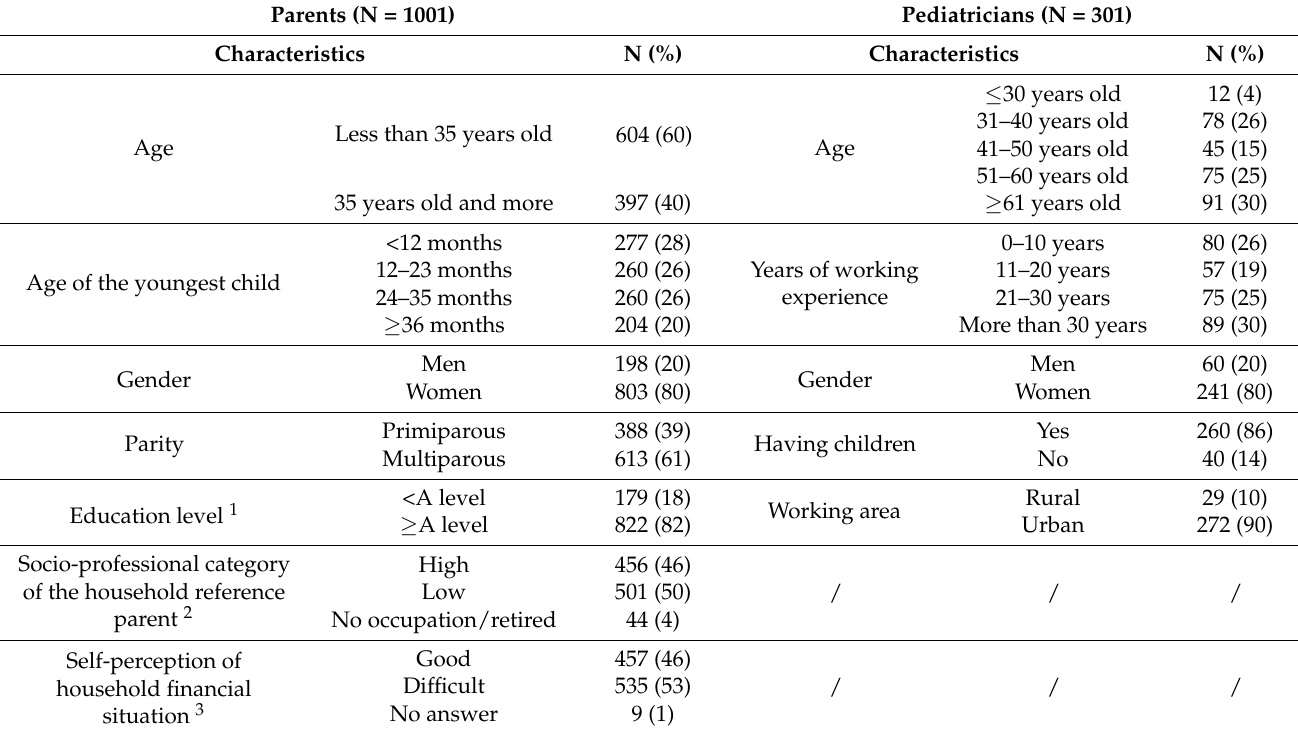
Table 1. Characteristics of French parents and pediatricians who responded to the